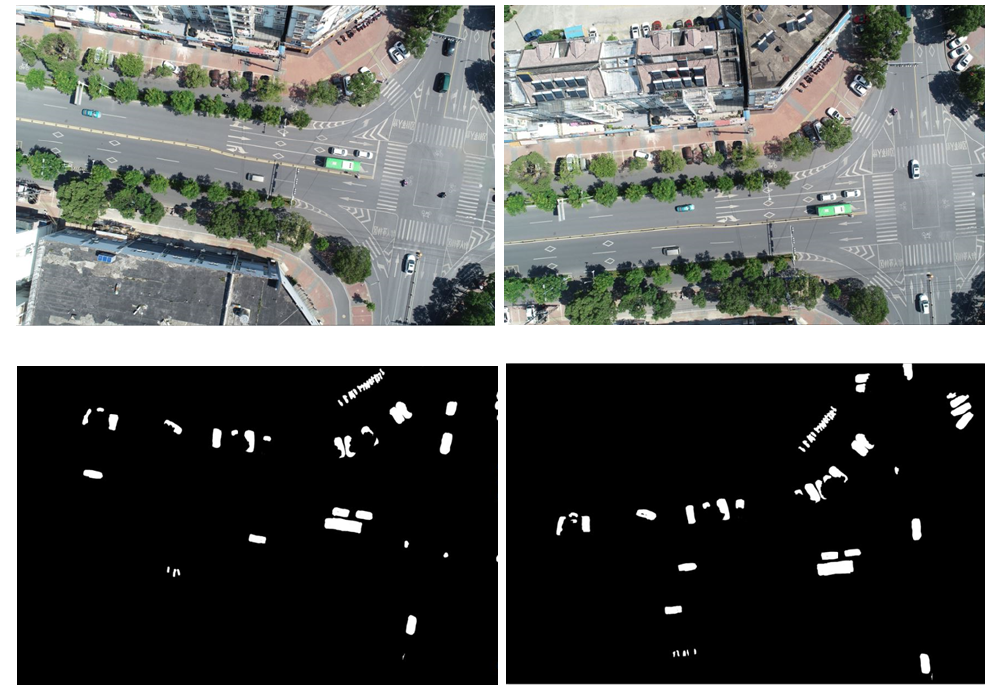
Figure 2. Schematic diagram of vehicle mask images. The first row is the original image; the second row is the moving vehicle mask of the original